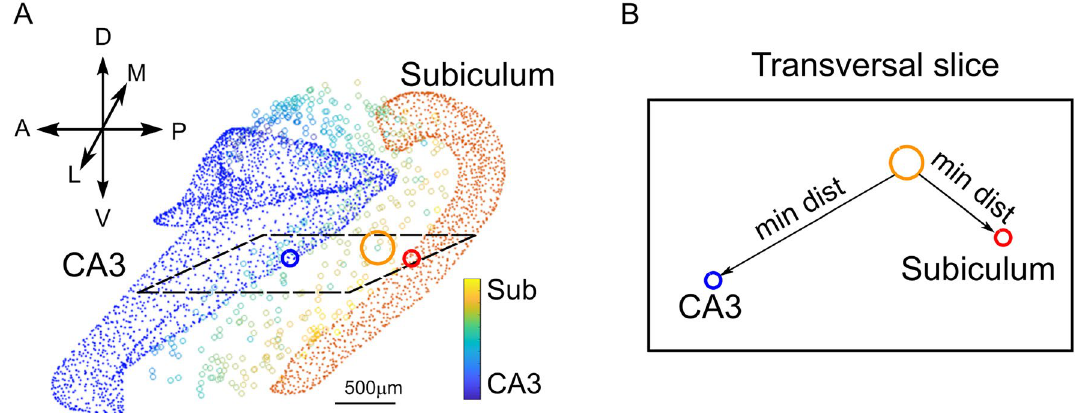
Figure 3. The PMA modeling. ( A ). Relative distance of CA1 PCs (colored circles) from either CA3 (blue dots) or Subiculum mesh (orange dots). Circles are colored according to a distance gradient (see color bar): from blue (PCs are closer to CA3) to yellow (PCS are closer to subiculum). ( B ). The plane formed from the two minimum distance vectors (see A) constitutes the transversal plane adopted to orient the major semiaxes of the axonal branch